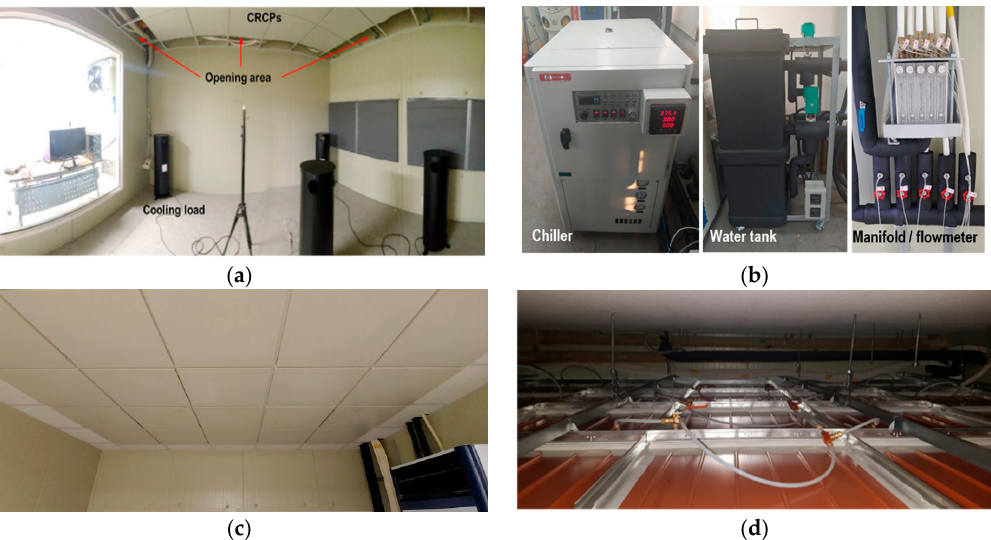
Figure 2. Developed test chamber: ( a ) inside view; ( b ) mechanical system; ( c ) CRCPs; ( d ) plenum space and upper side of CRCPs.